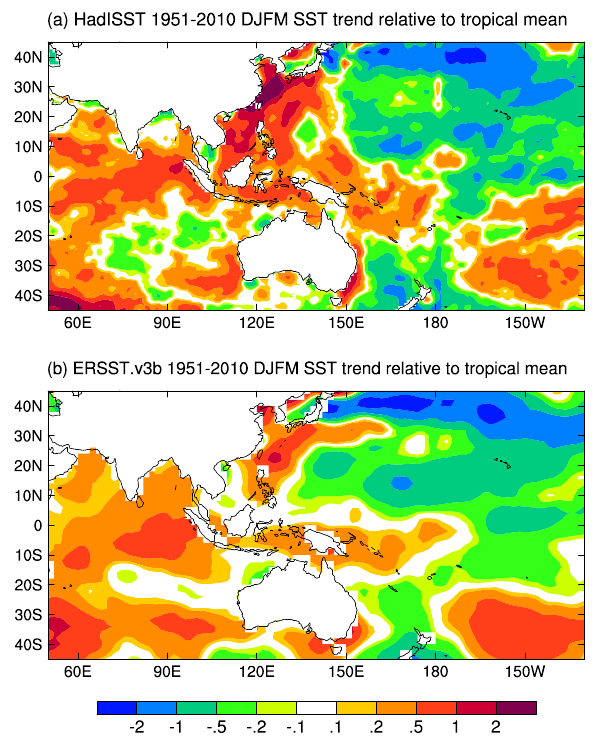
Fig. 23. Analysed DJFM SST trends for 1951–2010 with the low- latitude (30 ◦ S–30 ◦ N) mean trend subtracted (Kcentury − 1 ), (a) HadISST, (b)